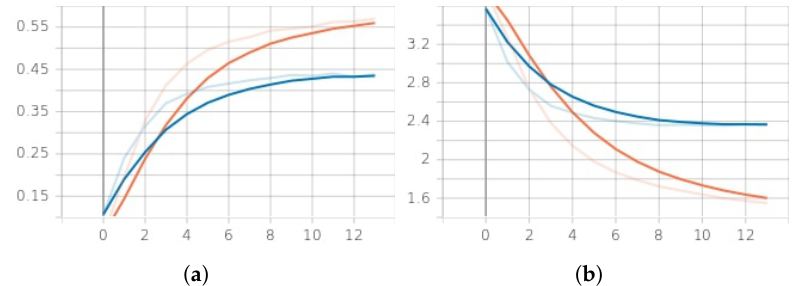
Figure 6. Training/validation accuracy vs. loss per epoch (12 epochs). ( a ) Training (red)/validation (blue) accuracy. ( b ) Training (red)/validation (blue)